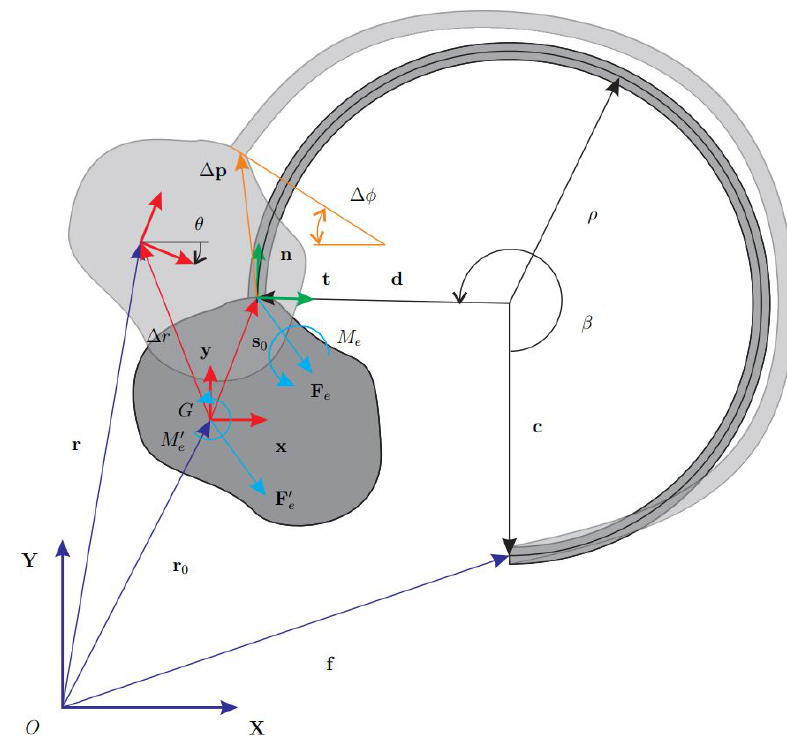
Figure 1. Layout of a